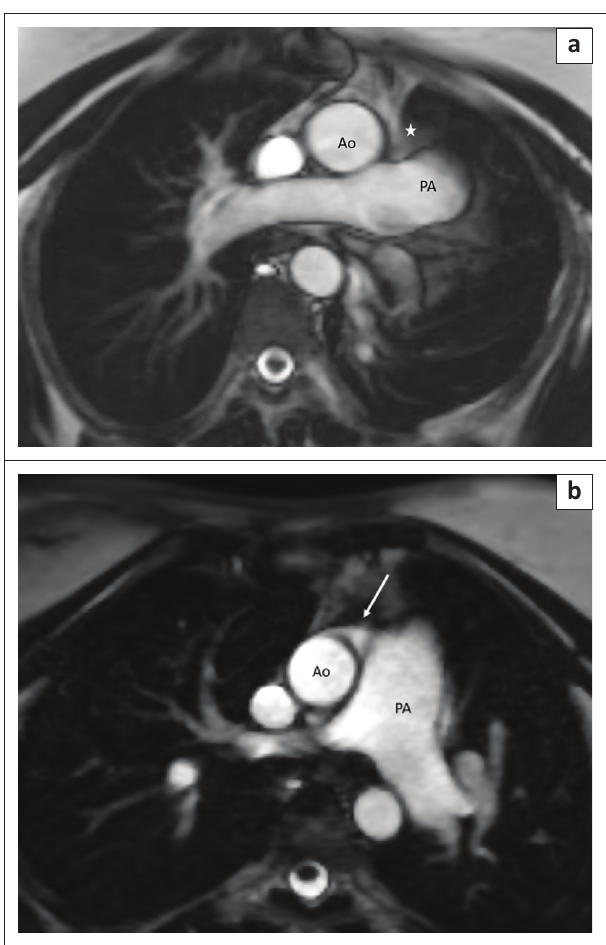
ba RA, right atrium; RV, right ventricle; LA, left atrium; LV, left ventricle. FIGURE 2: A 19-year-old man with absent pericardium. Axial SSFP image (a) demonstrates a horizontally orientated heart with absence of the pericardium across the atrioventricular (AV) groove (white arrow). Normally (b) the pericardium is seen as a thin grey line crossing the AV groove (white arrow) lateral to the right coronary artery (black